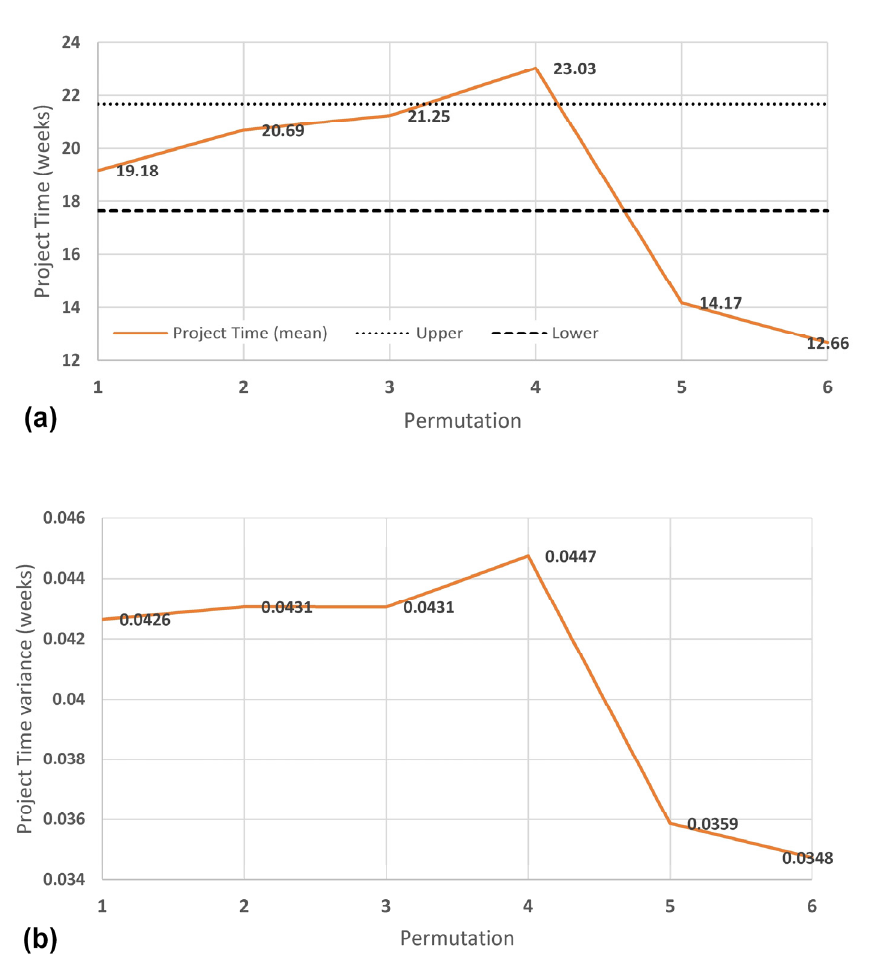
Figure 9. Project time estimates for each permutation and effective risk evaluated with RPI and QMI. ( a ) Project time estimates for each permutation. ( b ) Variance estimates for each permutation.